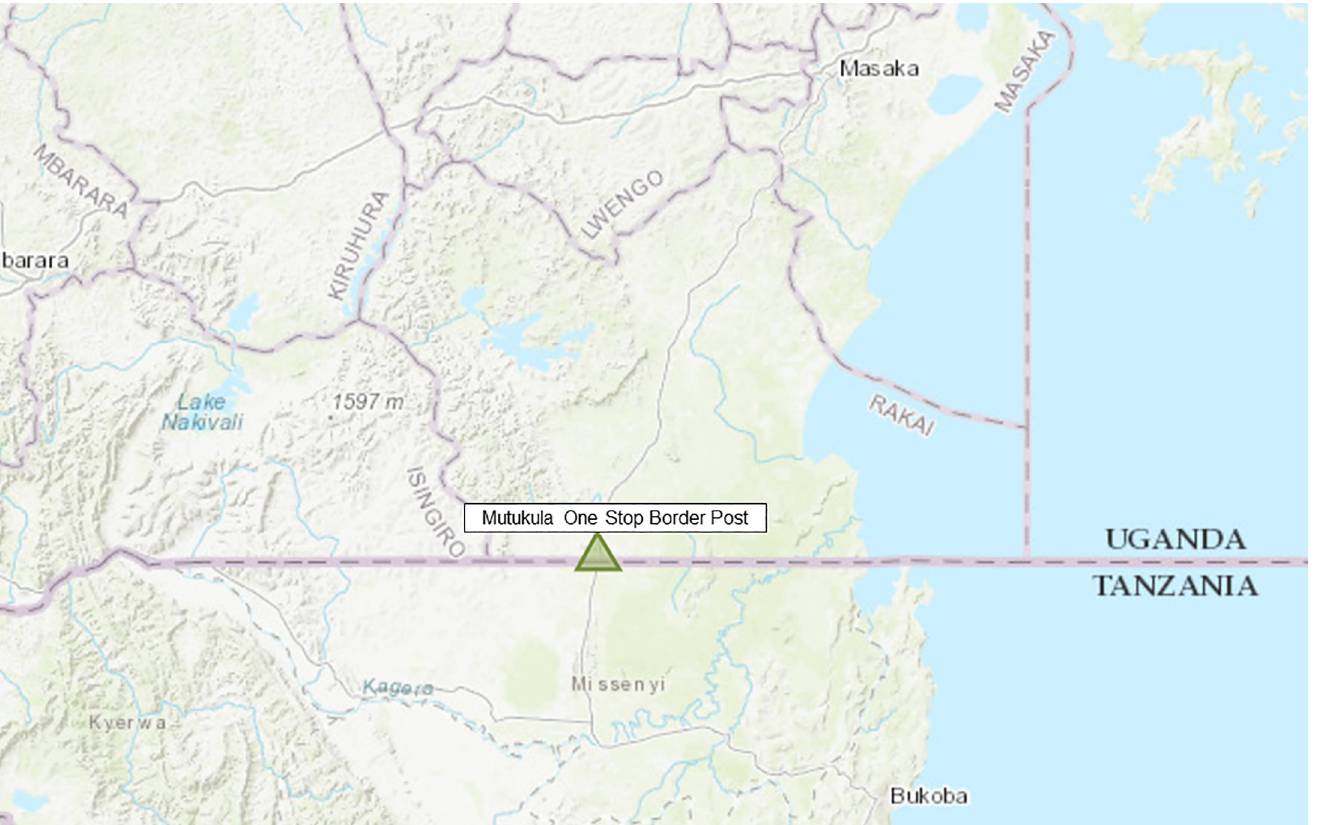
Fig 1. Location of Mutukula border entry point into Uganda.